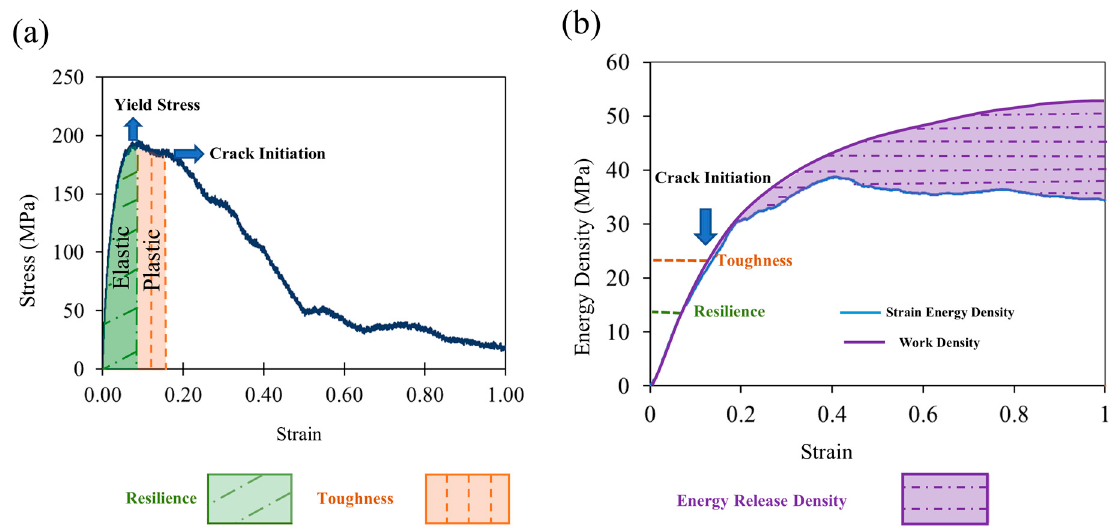
Figure 5. ( a ) Stress–strain response of silver doped PLA nanofibre diameter deformed in uniaxial tension. ( b ) Evolution of strain energy and work densities.